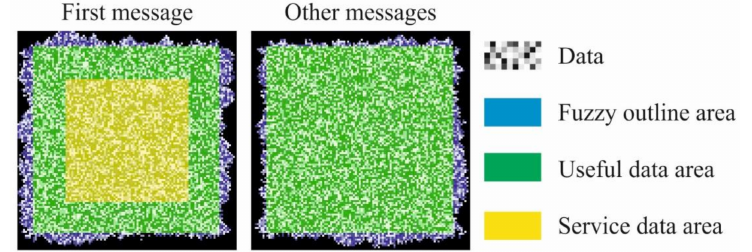
Figure 1. The structure of MCDDC’s messages (color online).